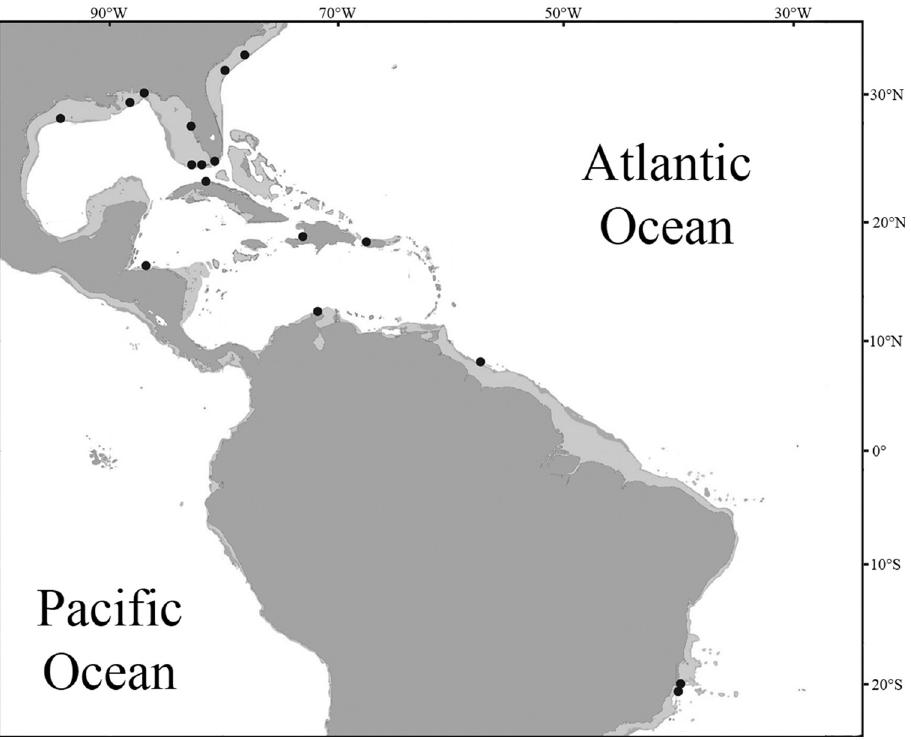
Figure 17. Distribution of Opistognathus lonchurus , including a few records from Robertson and Van Tassell